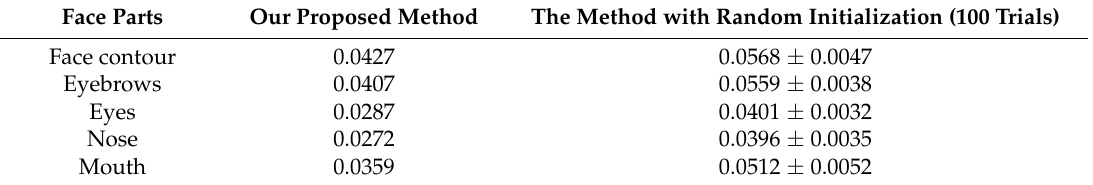
Table 2. Comparisons of normalized mean errors of our proposed method versus the method with random initialization for the K-means algorithm.